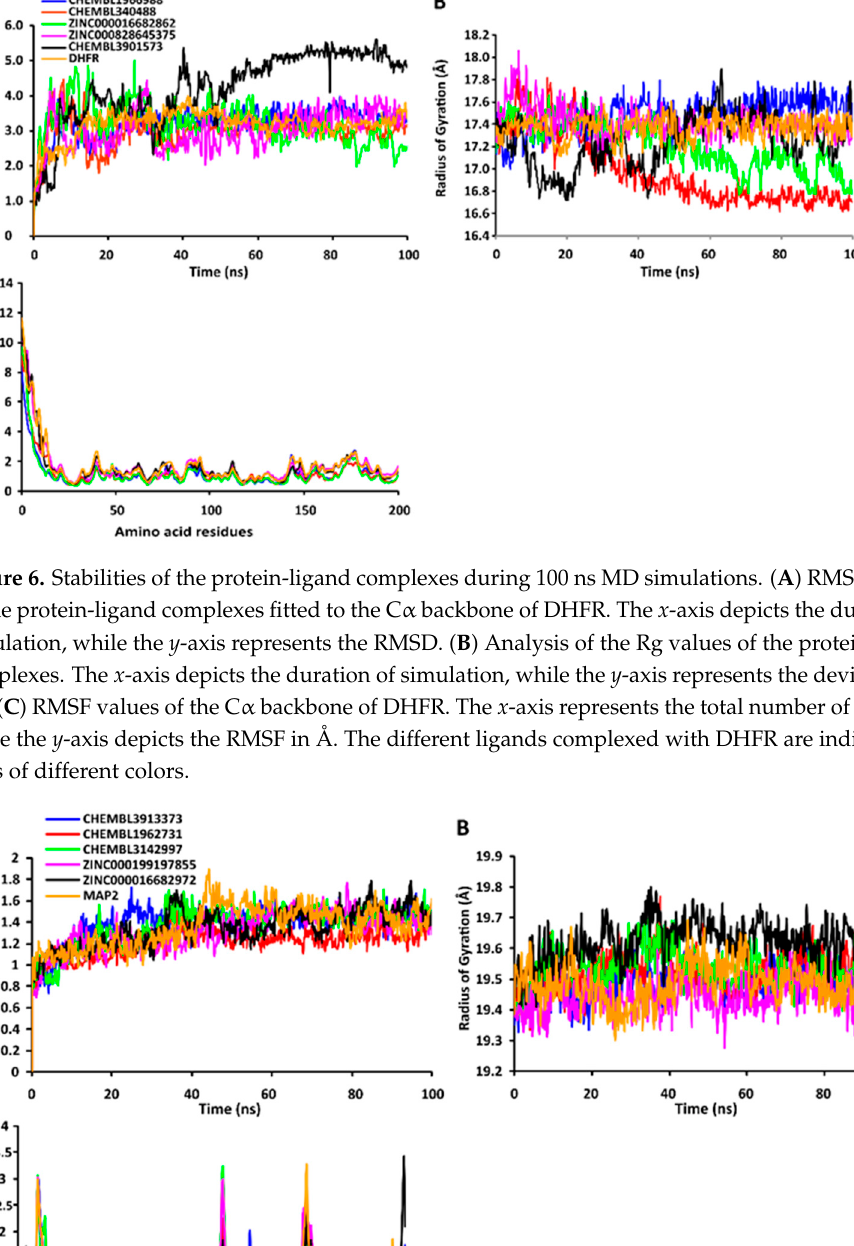
11 of 32 Figure 5. Stabilities of the protein–ligand complexes during 100 ns MD simulations. ( A ) RMSD val-